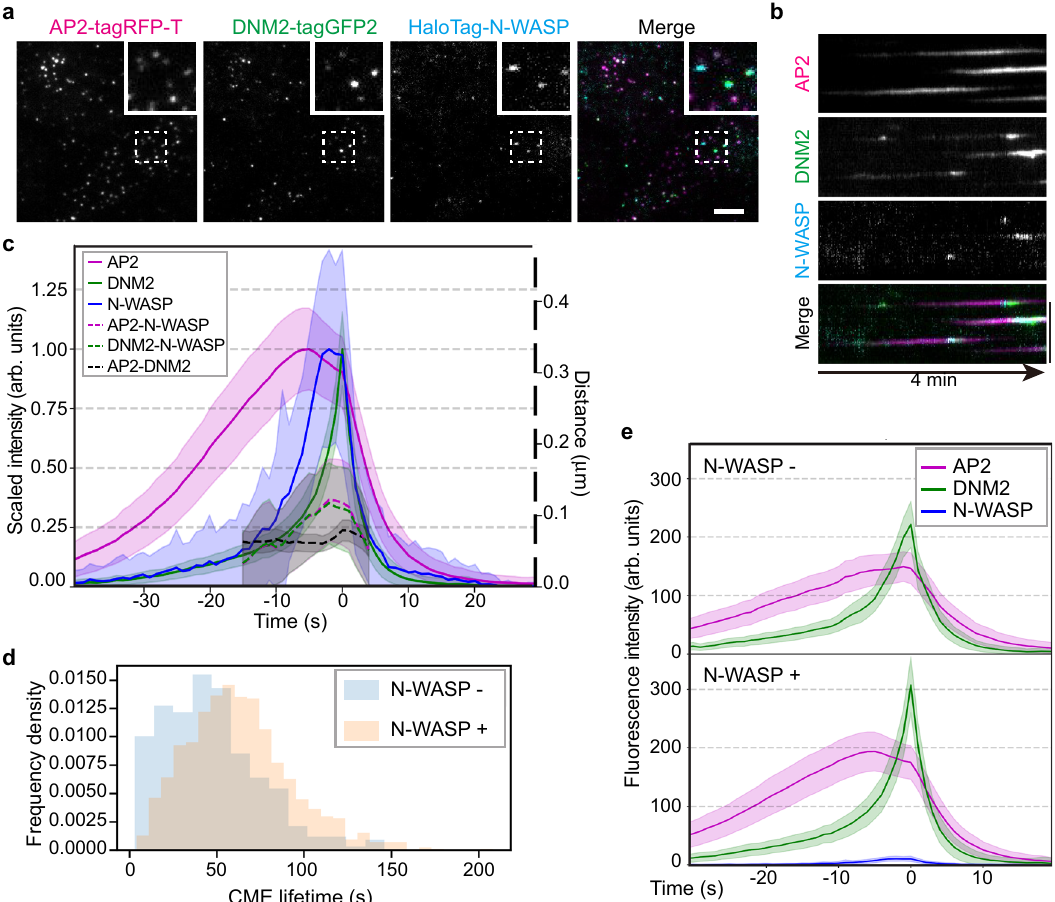
Fig. 6 Asymmetric N-WASP recruitment to stalled CME sites. a A representative single time frame image of a TIRF movie (Supplementary Movie 5) of AP2M1-tagRFP-T (magenta), DNM2-tagGFP2 (green) and JF635 ligand-conjugated HaloTag-N-WASP (cyan) in ADW cells. The highlighted region is boxed by a dashed line. Scale bar: 5 µ m. b A representative kymograph of CME sites in ADW cells over a 4 min movie. Scale bar: 5 µ m. c Averaged intensity (solid line) and distance (dashed line) vs time plots of N-WASP positive CME sites in ADW cells. Events are aligned to the frames showing the maximum DNM2 intensity. Intensity is scaled to 1 at peaks for each channel. Error bar: ¼ standard deviation. d N-WASP positive CME events have longer lifetimes. p-value from two-sided Welch ’ s t-test: 9.06e-20. e Intensity vs time plots of averaged N-WASP negative (top) and positive (bottom) CME sites in ADW cells. Events were aligned to the frames showing the maximum DNM2 intensity. Error bar: ¼ standard deviation. Source data are provided in the Source Data fi le. c , d N-WASP negative CME sites: N = 299, N-WASP positive CME sites: N =